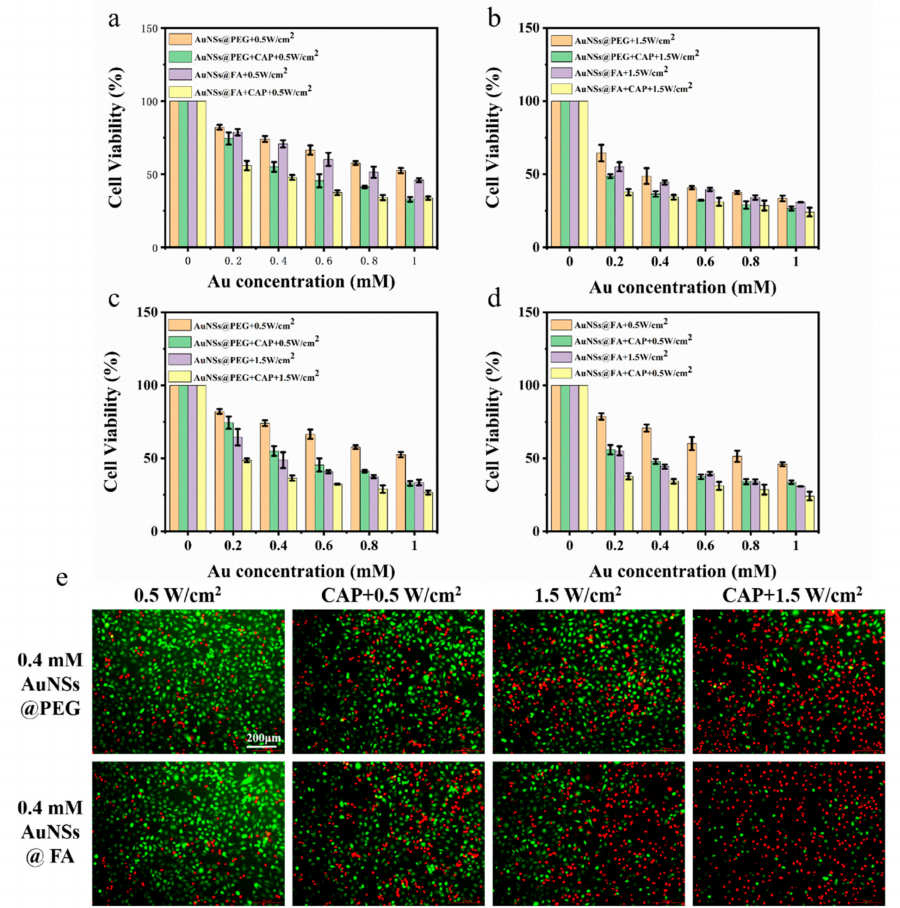
Figure 5. Cell viabilities of the 231 cells after NIR irradiation at 0.5 W/cm 2 ( a ) and 1.5 W/cm 2 ( b ), combined with CAP treatment. Cell viabilities of the 231 cells of AuNSs@PEG ( c ) and AuNSs@FA ( d ), after treatment with different laser irradiations (0.5 W/cm 2 or 1.5 W/cm 2 ) and CAP. ( e ) Live/dead assays of the 231 cells with the different treatments at an Au concentration of 0.4 mM (Green, lIVE; Red,